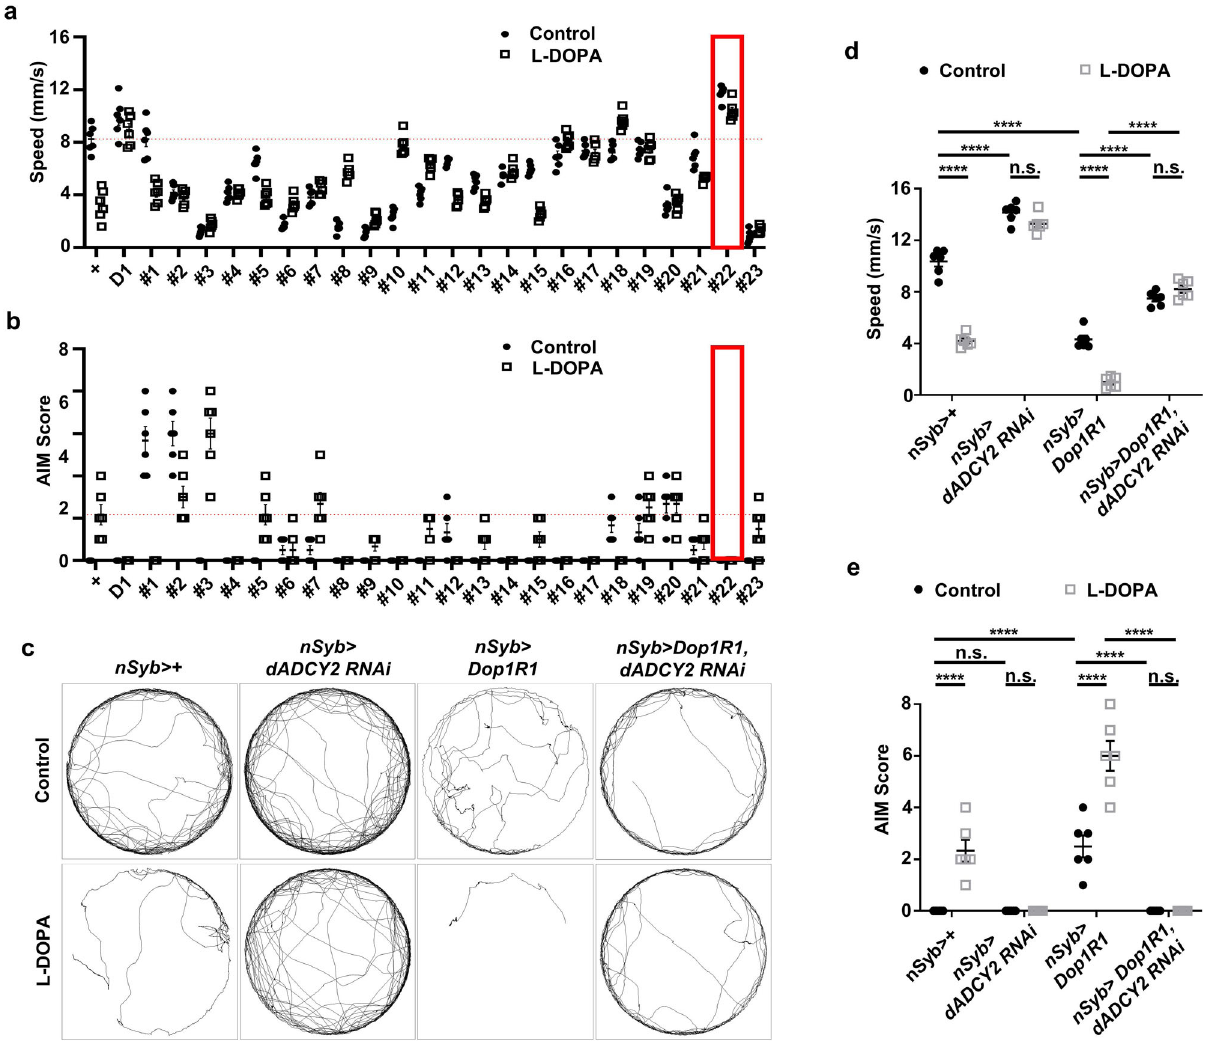
Fig. 6 dADCY2 functions downstream of Dop1R1 for LID-related phenotypes. a , b Comparisons of the quanti fi ed speed ( a ) and AIM scores ( b ) of the fl ies in which twenty-three LID-related genes were pan-neuronally knocked down by RNAi expression driven by nSyb-GAL4 . + denotes the fl ies bearing a copy of nSyb-GAL4 driver with no RNAi expression. D1 indicates the fl ies expressing Dop1R1 RNAi driven by nSyb-GAL4 . Red boxes indicate Drosophila ADCY2 RNAi driven by nSyb-GAL4 . Black (control) and white bars (L-DOPA) indicate control and L-DOPA diet. The mean speed and AIM score are depicted in red line. N = 6. c Representative trajectories of the fl ies with indicated genotypes upon control and L-DOPA diet. d , e Comparisons of the quanti fi ed speed ( d ) and AIM scores ( e ) of the fl ies with indicated genotypes. N = 6. **** p < 0.0001; n.s., not signi fi cant ( p > 0.05) by two-way ANOVA Tukey ’ s multiple comparison test. Data are presented as means± SEM. p < 0.05 was considered statistically signi fi